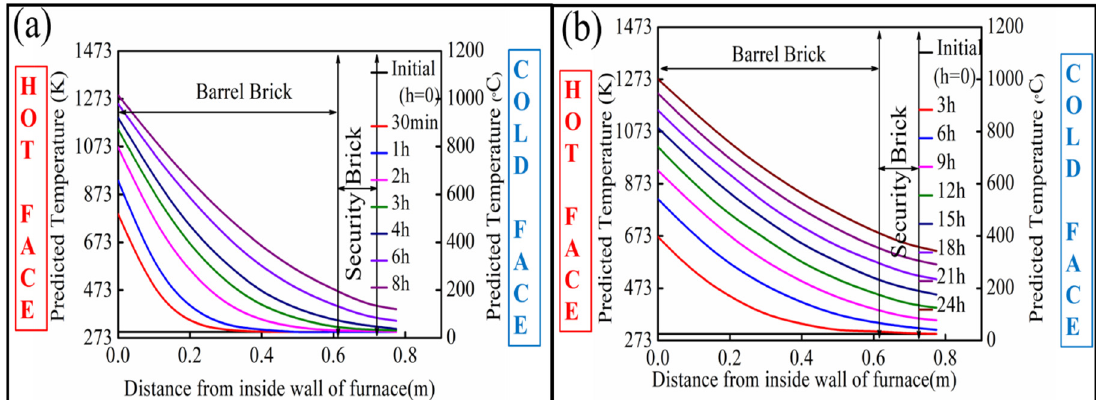
Figure 3. Heat up curve of the bricks: ( a ) in the current preheating procedure (8 h), ( b ) for the future preheating procedure (24 h).